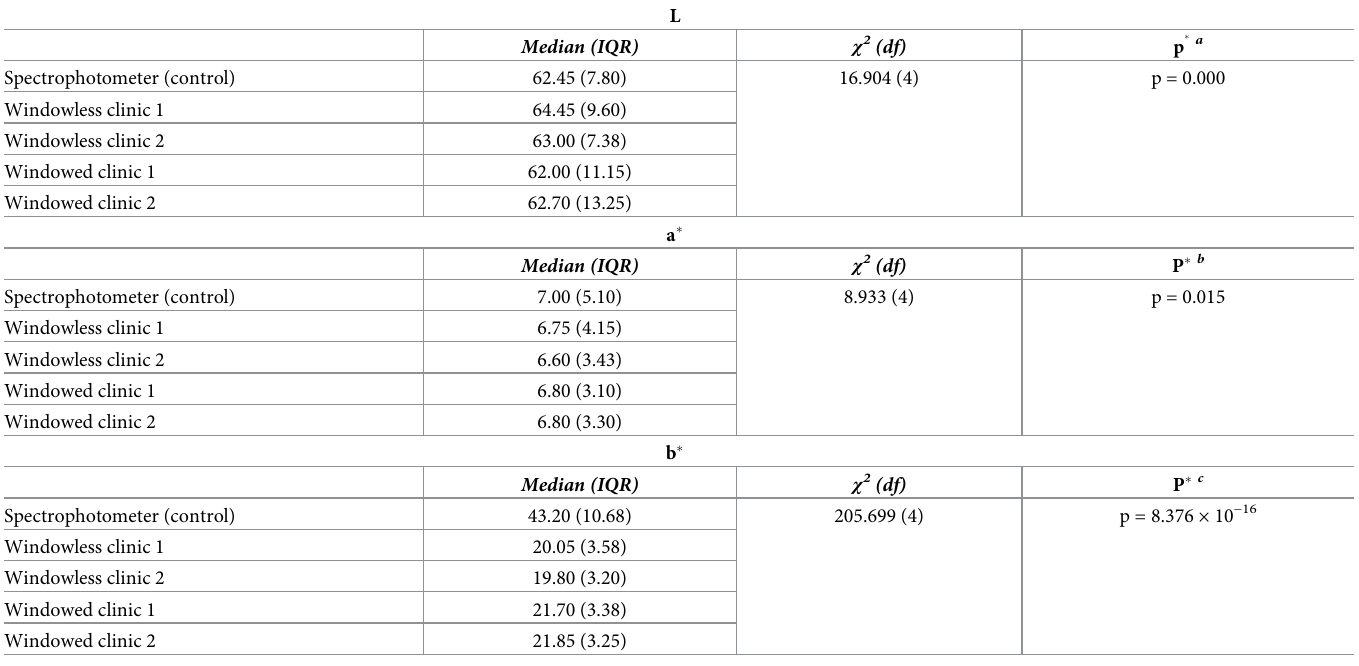
Table 4. Comparison of L, a � and b � values for images with post processing white balance correction using Macbeth color